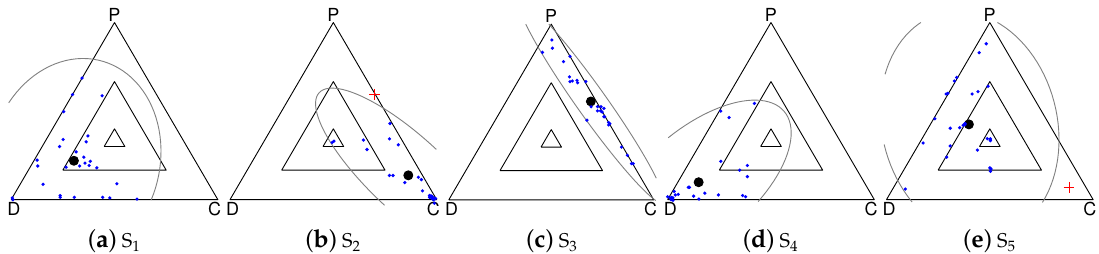
Figure 6. Raw data of experiment 3 for each condition showing all data points (blue points) within a Mahalanobis distance of three estimated standard deviations (gray ellipses) around the preliminary mean value (black dot) to find outliers (red